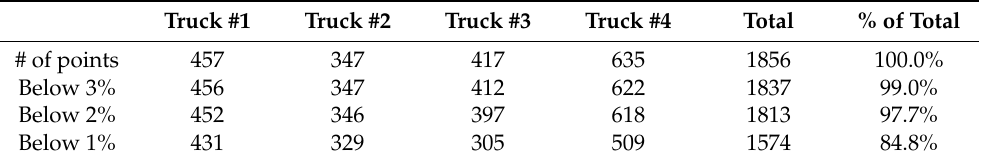
Table 2. The number of points for which the ratio CO/CO 2 concentrations were below 3%, 2%, and 1%.